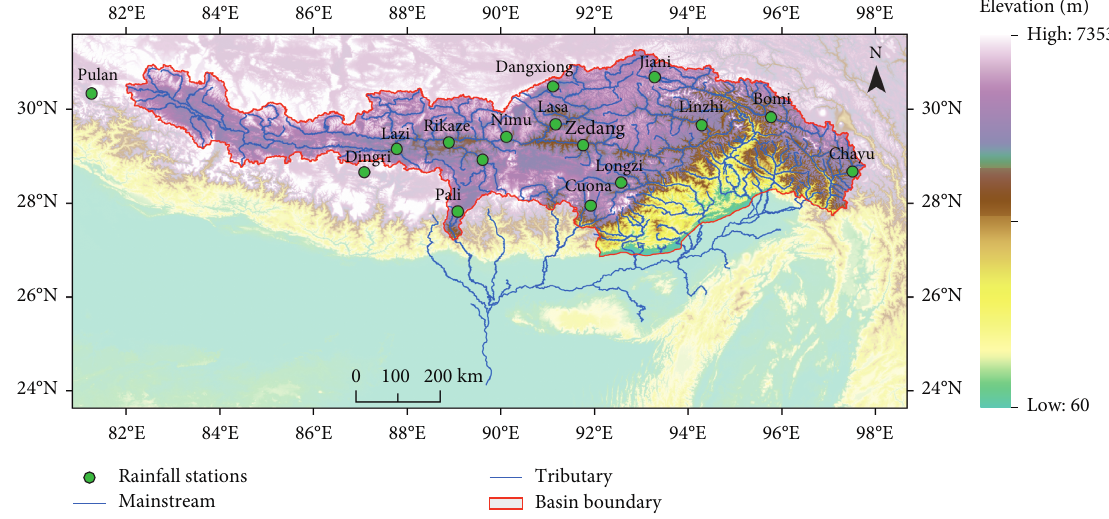
Figure 1: The location and distribution of meteorological stations in the Table 1: Geographical coordinates, annual mean precipitation (P), coefficient of variation (VC), and mean number of rainy days ( N ) for the 16 stations considered in this study.